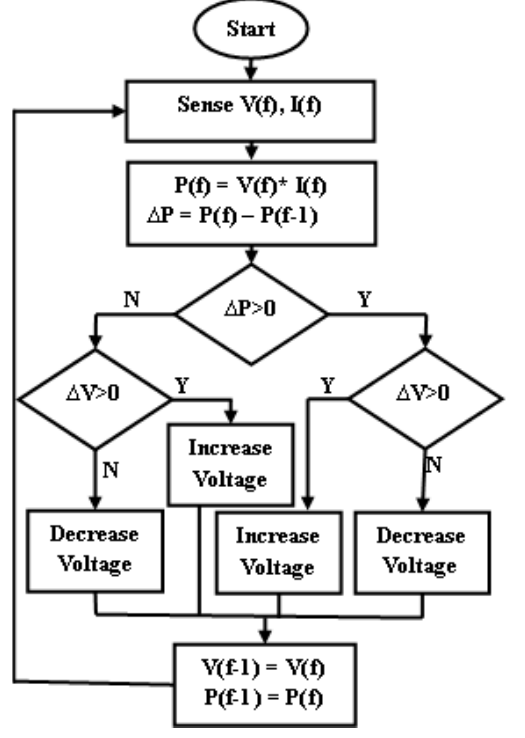
Figure 6. Flowchart of P&O